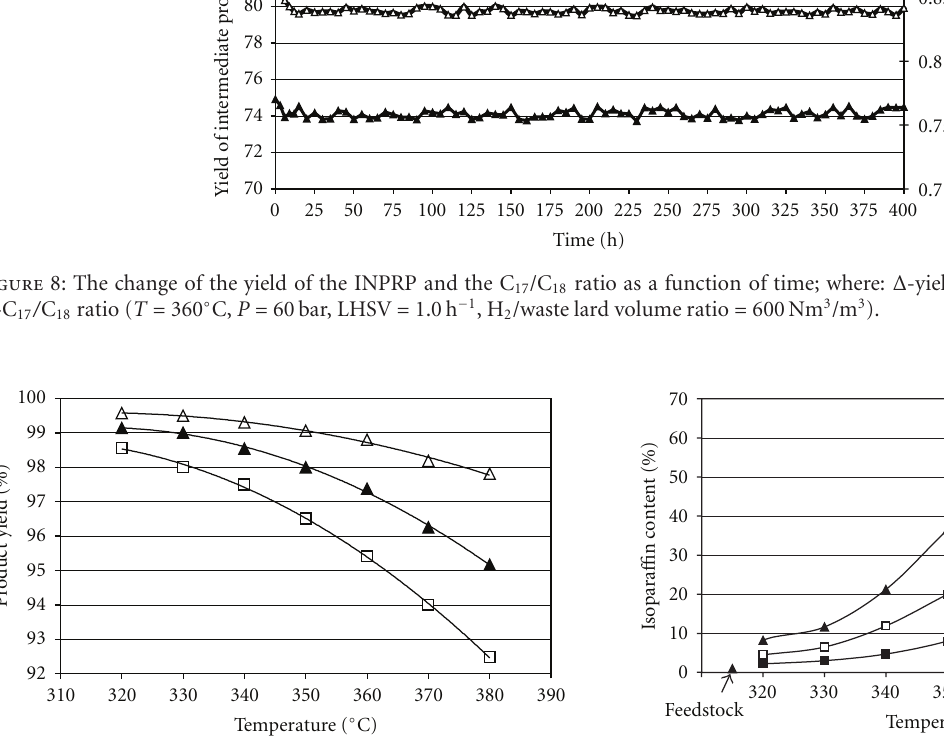
Figure 11: The isopara ffi n content of the products as a function of temperature and LHSV; where: of LHSV ( P = 40bar, H 2 /hydrocarbon volumeratio = 400Nm 3 /m 3